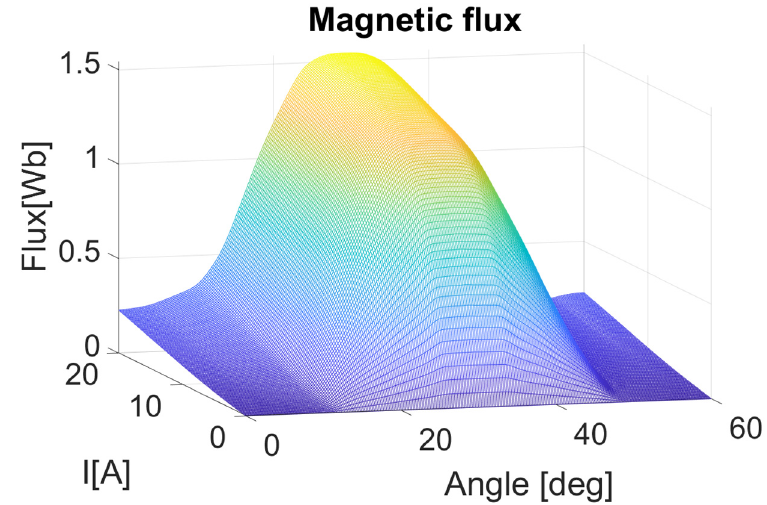
Figure 11. Flux mesh graph of one phase at different current and angle values.